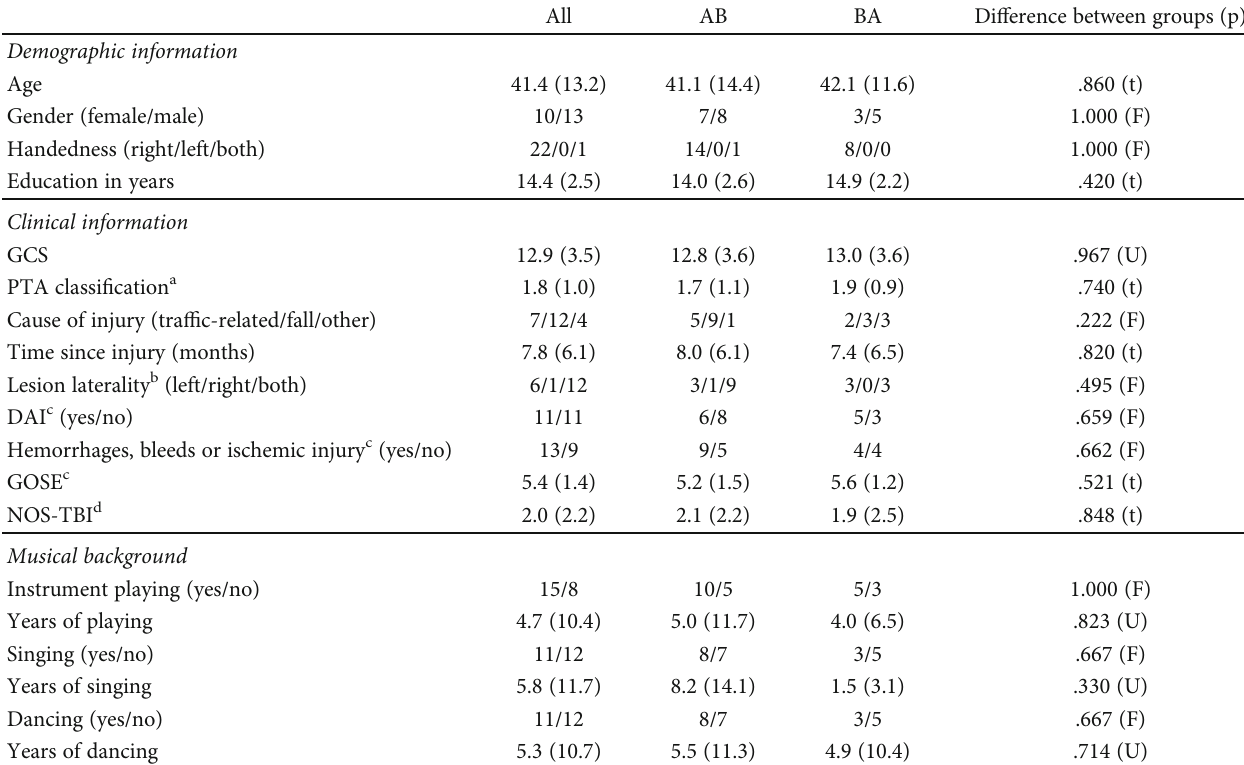
Table 1: Demographic, clinical, and musical background information ( N = 23 TBI